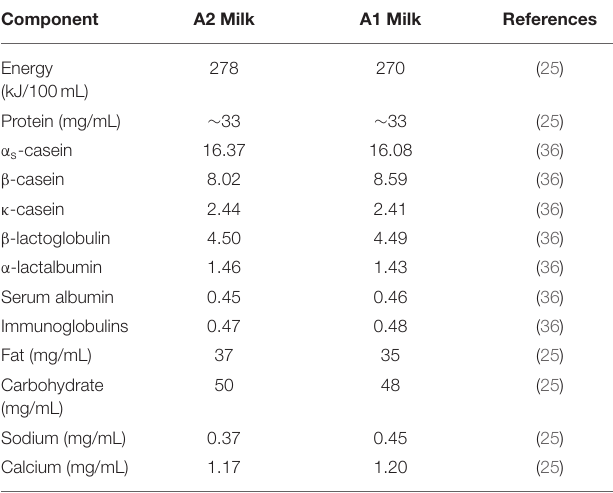
TABLE 1 | Comparison of the nutritional content of A1 and